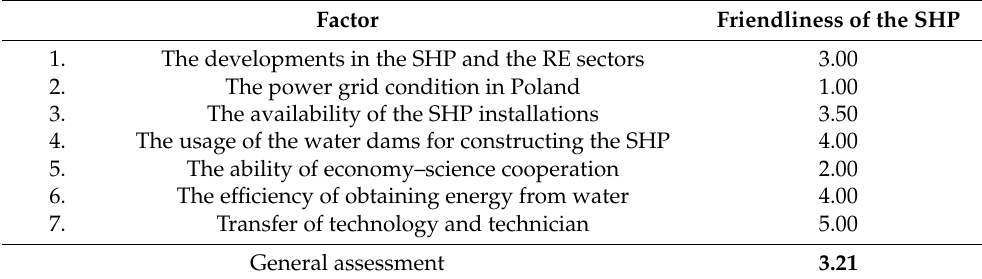
Table 4. The technological environment of the SHPs in Poland in the context of its development